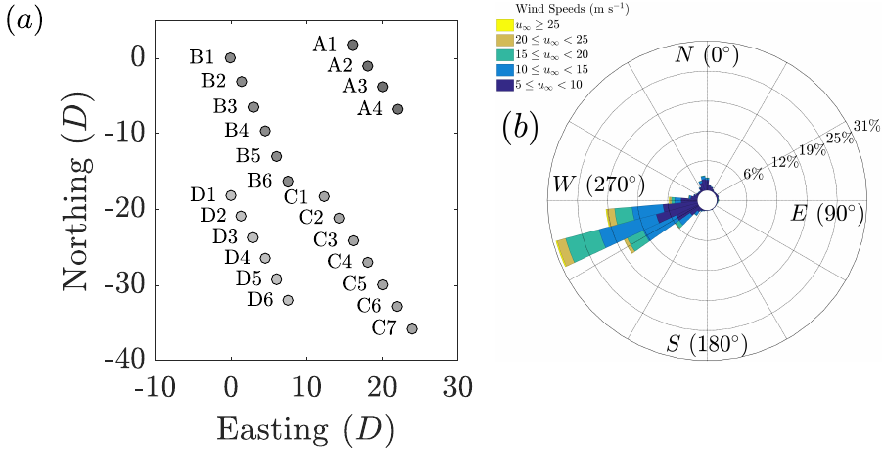
Figure 3. ( a ) Summerview wind farm in Alberta, Canada oriented with the cardinal directions, viewed from above. The circles have a diameter of approximately D . Turbines within each column are numbered north to south. ( b ) Wind rose for the Summerview wind farm measured by Turbine